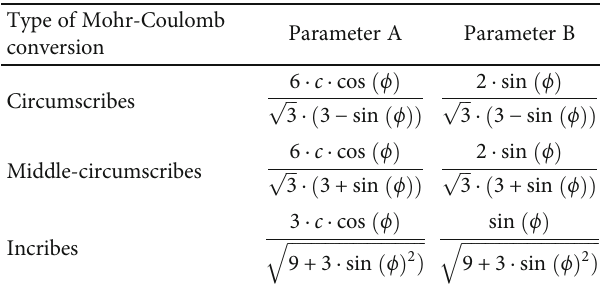
Table 1: Parameters A and B depending on the type of surface surrounding the Mohr-Coulomb yield